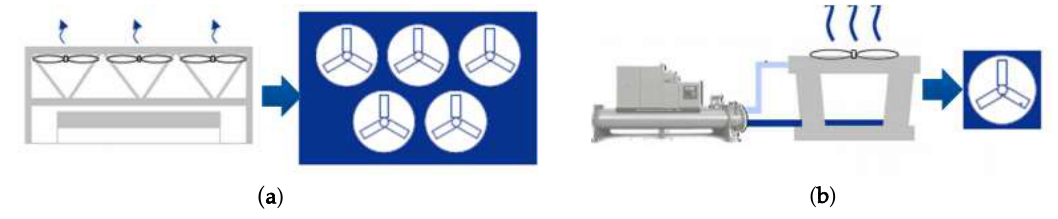
Figure 9. Comparison of ( a ) air- and ( b ) water-cooled systems [18].